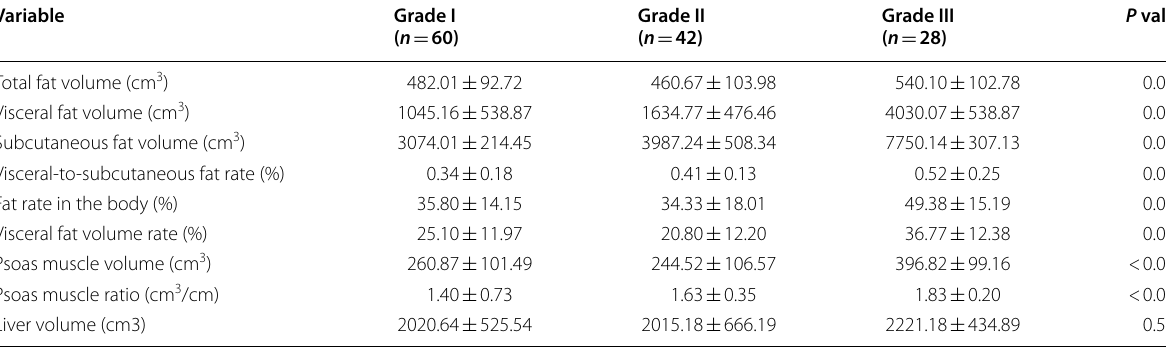
Data expressed as mean (SD). P value was significant if < 0.05